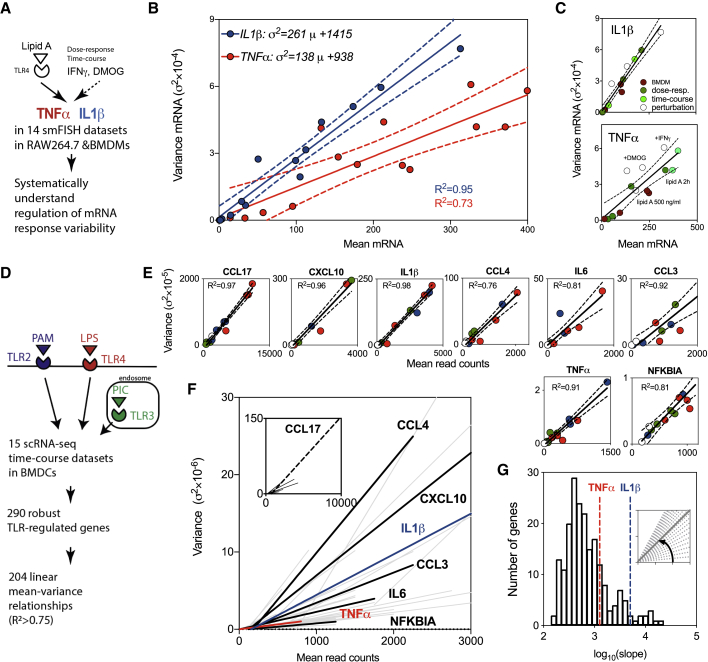
Single-Cell Expression is Constrained by Gene-Specific Linear Trends(A) Analysis of single-cell variability in TNF-α and IL-1β mRNA expression across 14 smFISH measurements; dose response in RAW 264.7 and BMDM cells; time course in RAW 264.7 as well as DMOG and IFNγ co-stimulation in RAW 264.7 cells.(B) Mean-variance relationship obtained for smFISH data for IL-1β and TNF-α. Shown is the fitted regression line (with 95% confidence intervals in broken lines), together with individual data points. Coefficient of determination depicted with R2 and color coded. Fitted equations displayed on the graph.(C) Visualization of samples across data in (B). Individual data points colored and labeled: green- RAW 264.7 dose-response data; light green, RAW 264.7 time course data; open circles, RAW 264.7, DMOG, and IFNγ co-stimulation data; and brown, BMDM dose-response.(D) Inference of mean-variance relationships from the scRNA-seq data from (Shalek et al., 2014). BMDCs either untreated or stimulated with TLR2, 3, and 4 ligands for 1, 2, 4, or 6 h. For each TLR-dependent gene in the dataset, mean and variance of read count expression across all conditions are fitted using robust linear regression.(E) Analysis of mean-variance relationships in selected TLR-induced genes. Shown are the fitted linear regression lines (with 95% confidence intervals) for highlighted genes from (Shalek et al., 2014). Different TLR treatments color coded as in (D) (open circles, untreated controls). Coefficient of determination depicted with R2.(F) Linear mean-variance regression trends for 204 high-confidence genes inferred from (Shalek et al., 2014). Highlighted genes depicted in black, trends for IL-1β and TNF-α in blue and red, respectively.(G) Distribution of fitted regression slopes from (F) (in log10). Slopes for IL-1β and TN-Fα regression fits highlighted in blue and red lines, respectively.